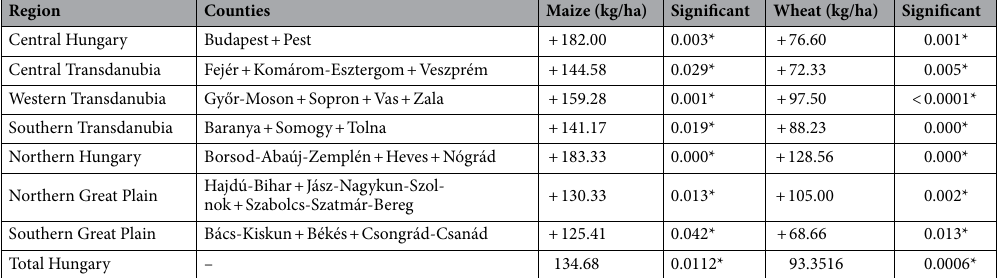
Between 2000 and 2020, the SYRS analysis for crop yield depicted a notable decrease (i.e., SYRS < − 1.5), namely in 2000, 2003, 2007, 2012–2013 (Fig. 10). For maize yield, the lowest SYRS value was recorded in South- ern Transdanubia (− 2.29, 2012), followed by Southern Great Plain region (− 2.25, 2012), then Northern Hungary (− 2, 2015) and Central Hungary (− 1.96, 2007) (Fig. 10). On the other hand, the lowest the lowest SYRS value for wheat crop was recorded in Central Transdanubia region (− 2.54, 2003), then in Western Transdanubia region (− 2.19, 2003) (Fig. 10). Notably, the following years 2003, 2007 and 2012 witnessed a direct impact of climate on maize yield losses, while 2003 was a drastic year for wheat production in Hungary. It is good to mention here, according to SYRS analysis the wheat yield was less exposure and affected by drought episodes in comparison with maize. As such, the wheat crop appears to be more drought resistant than maize across Hungary. Drought impact on maize and wheat yield. To capture the direct impact of drought spells on crop yield across different regions of Hungary during the period of this study, we determined the Pearson correlation coefficients ( r ) between drought indices (SPI-3, SPEI-3, SPI-6, SPEI-6) and the SYRS for wheat and maize on a monthly